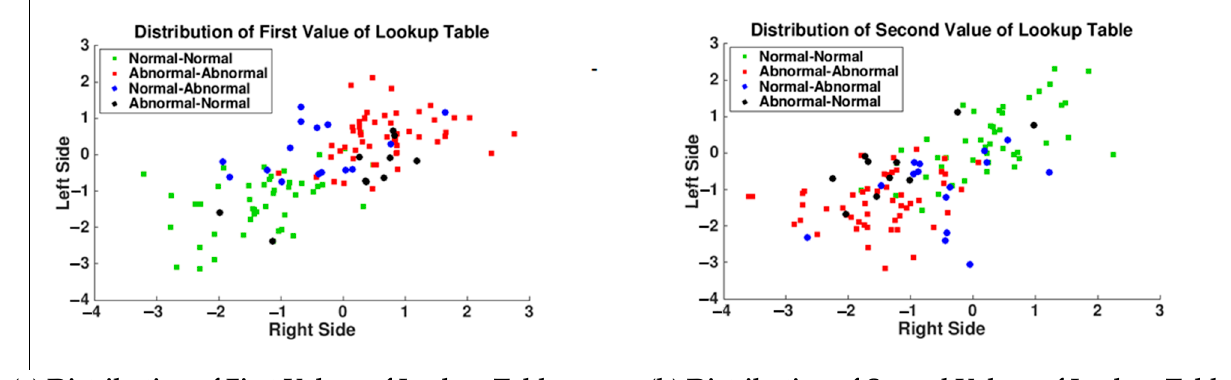
Figure 5. Lookup value distribution of Right and Left side of eardrum for Normal-Normal, Abnormal-Abnormal, Normal- Abnormal, and Abnormal-Normal pairs. While Normal-Normal pairs first lookup table values located in the lower-left corner and Abnormal-Abnormal pairs first lookup table values located in the upper-right corner of Figure 5a, and vice versa for Figure 5b. The first values of right and left normal pairs (N-N) were less than zero, and for abnormal pairs (A-A), the same values were greater than − .5 (Figure 5a). For the second lookup table values, N-N and A-A pair corners switched (Figure 5b). Our expectation was Normal-Abnormal pairs would state on the upper-left, and Abnormal-Normal pairs would state on the lower-right corner of Figure 5a, and vice versa for Figure 5b. However, Normal-Abnormal and Abnormal-Normal pairs stated mixed into other pairs. The number of Normal-Abnormal and Abnormal-Normal pairs are very limited, and most of them are subtle.